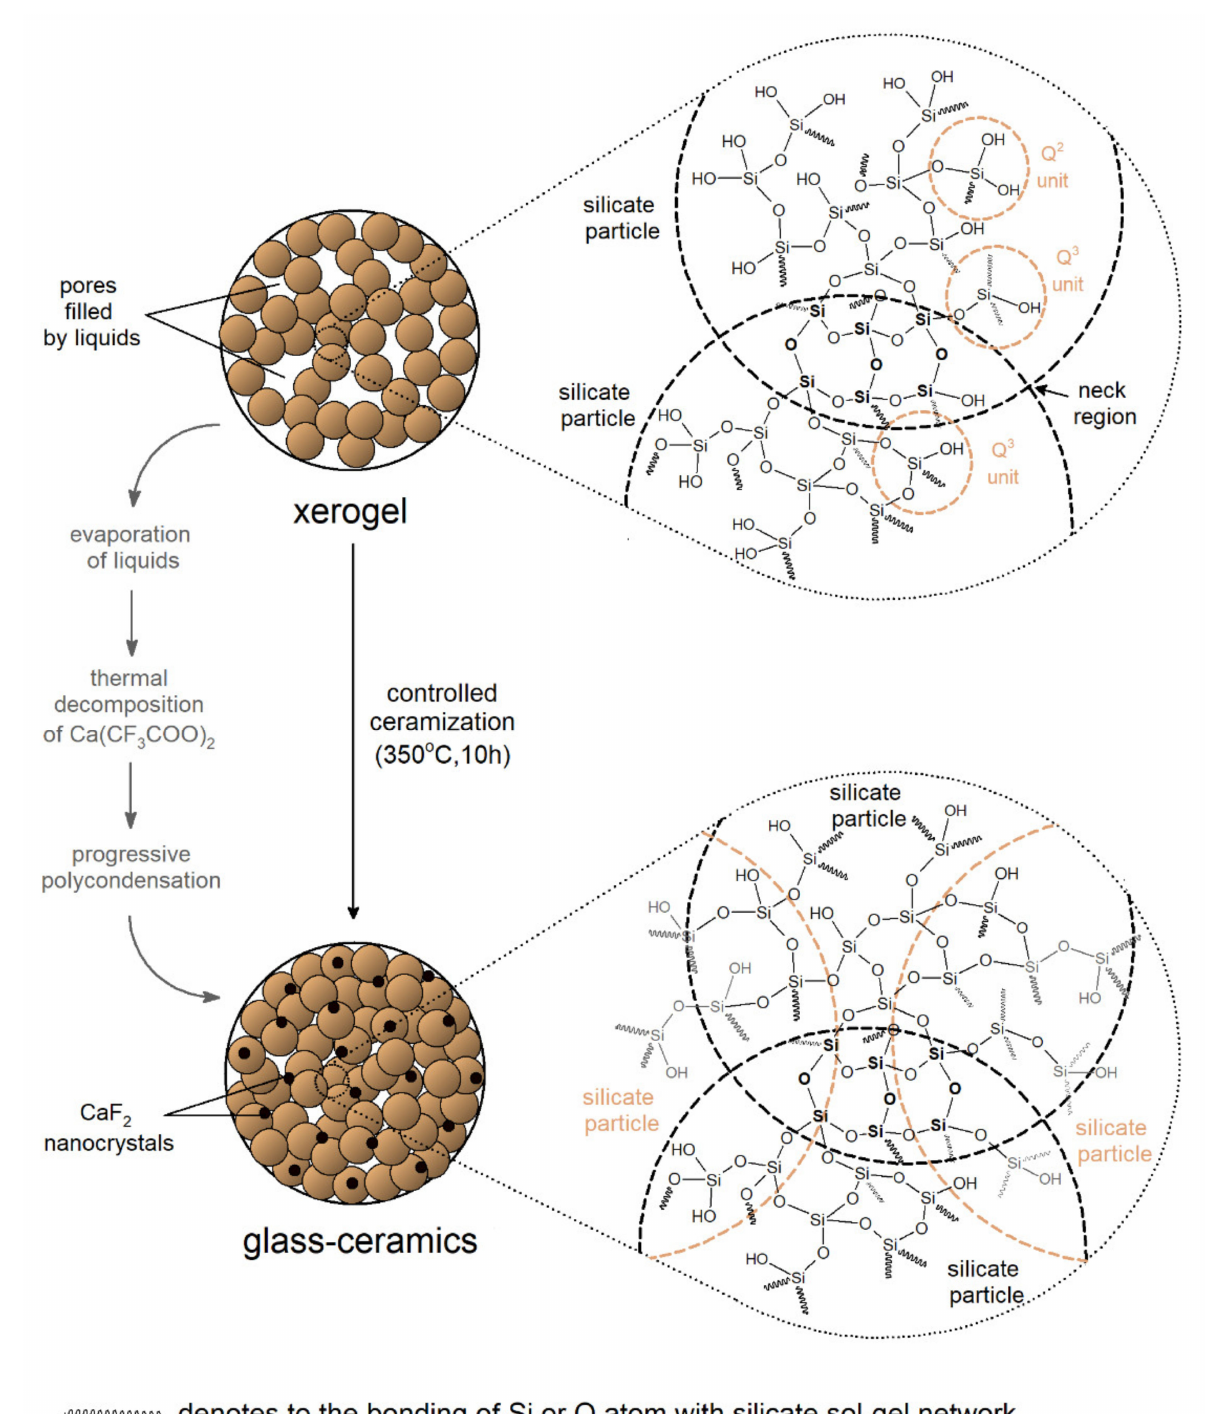
Figure 3. Graphical representation of structural transformation during controlled ceramization at 350 ◦